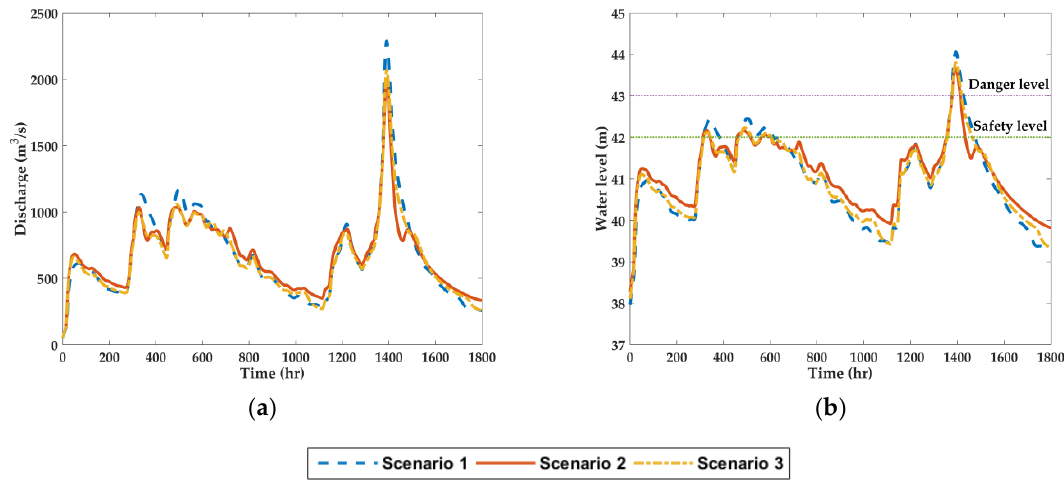
Figure 6. Simulation results at Taungoo with respect to three operation scenarios: ( a ) Discharge and ( b ) water levels.